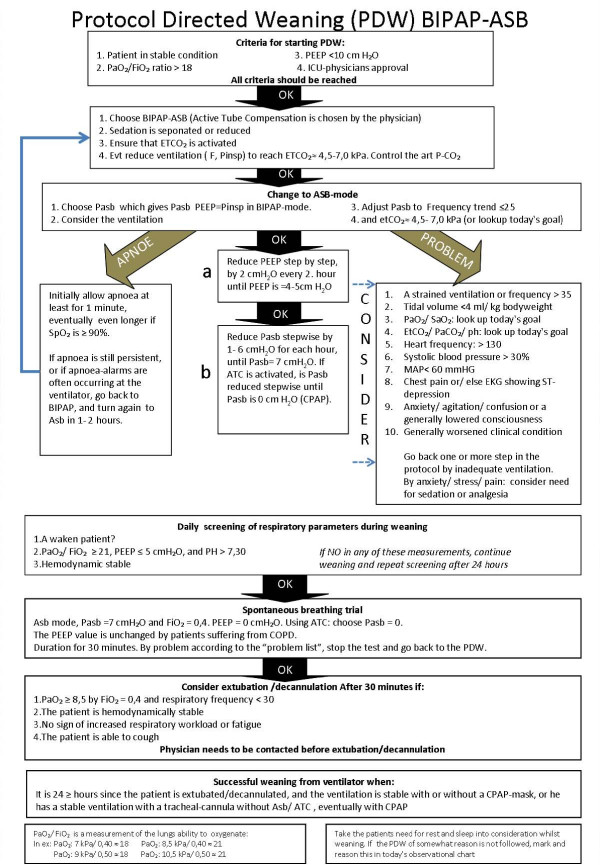
Weaning protocol (Appendix).